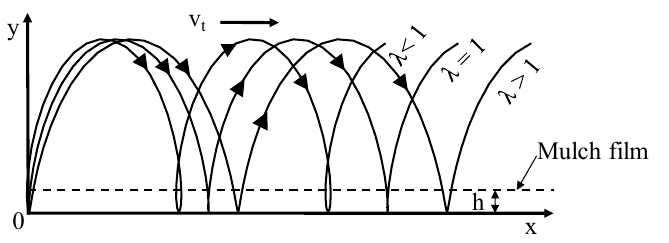
Figure 4. Possible trajectory of the dibbling hopper during transplanting operations in a mulch film ridge for different forward speeds of the transplanter.